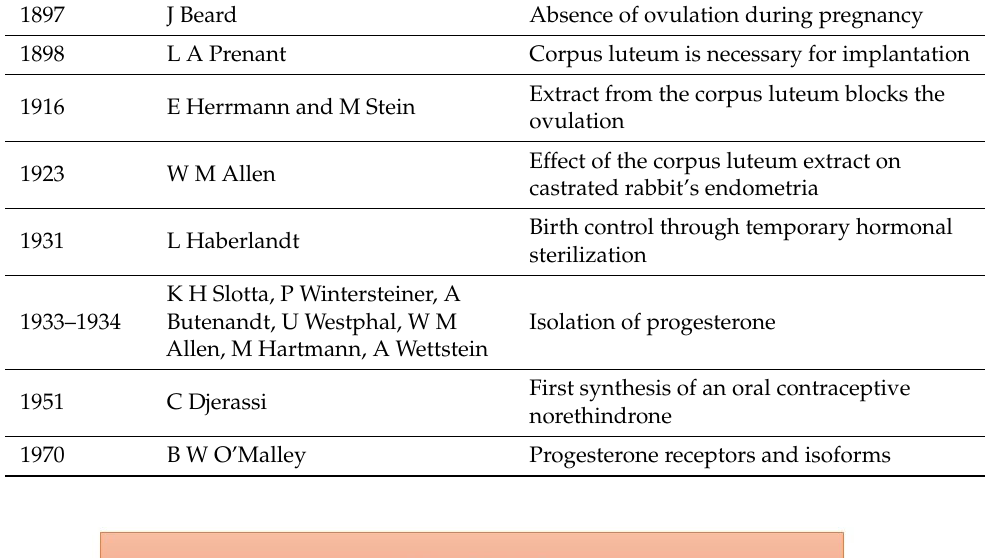
Table 1. Major milestones of progesterone research.